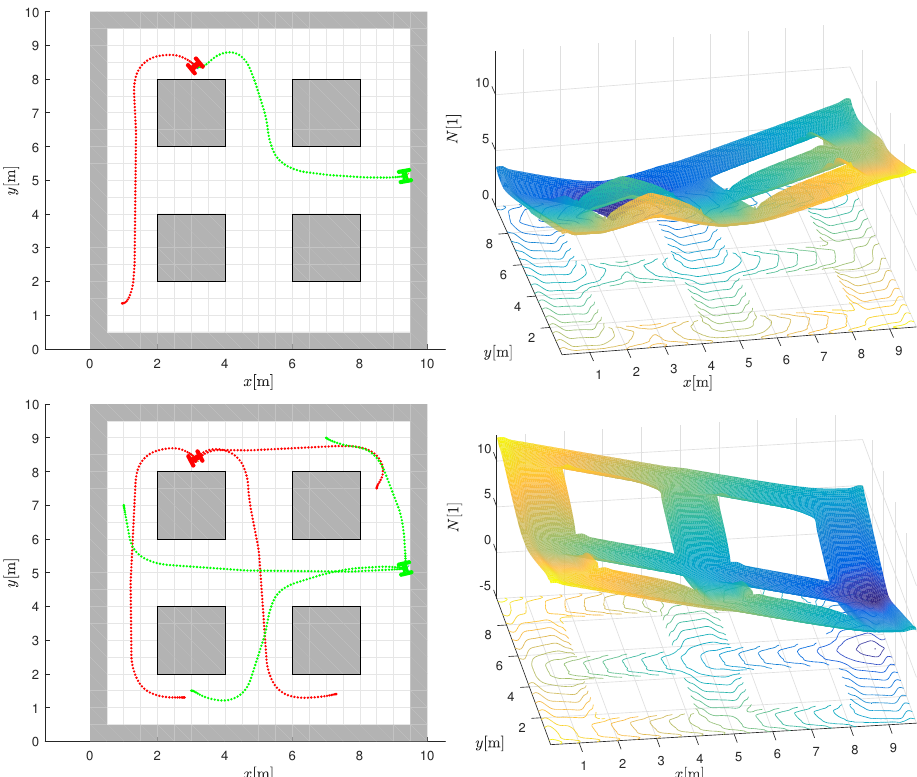
Figure 7. Examples of navigation and control of a single robot in two different destinations defined by the minimum values of the navigation functions in the right column. All red paths are obtained by the navigation function in the top right image, while the green paths are obtained by the navigation function in the bottom right